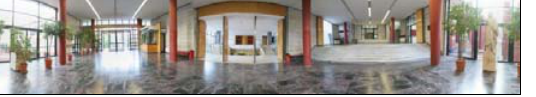
Figure 9. Camera position over the tripod, the plump line and the electronic compass.